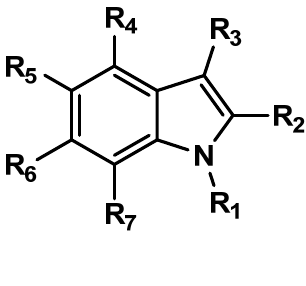
Table 3. Molecular structures of the